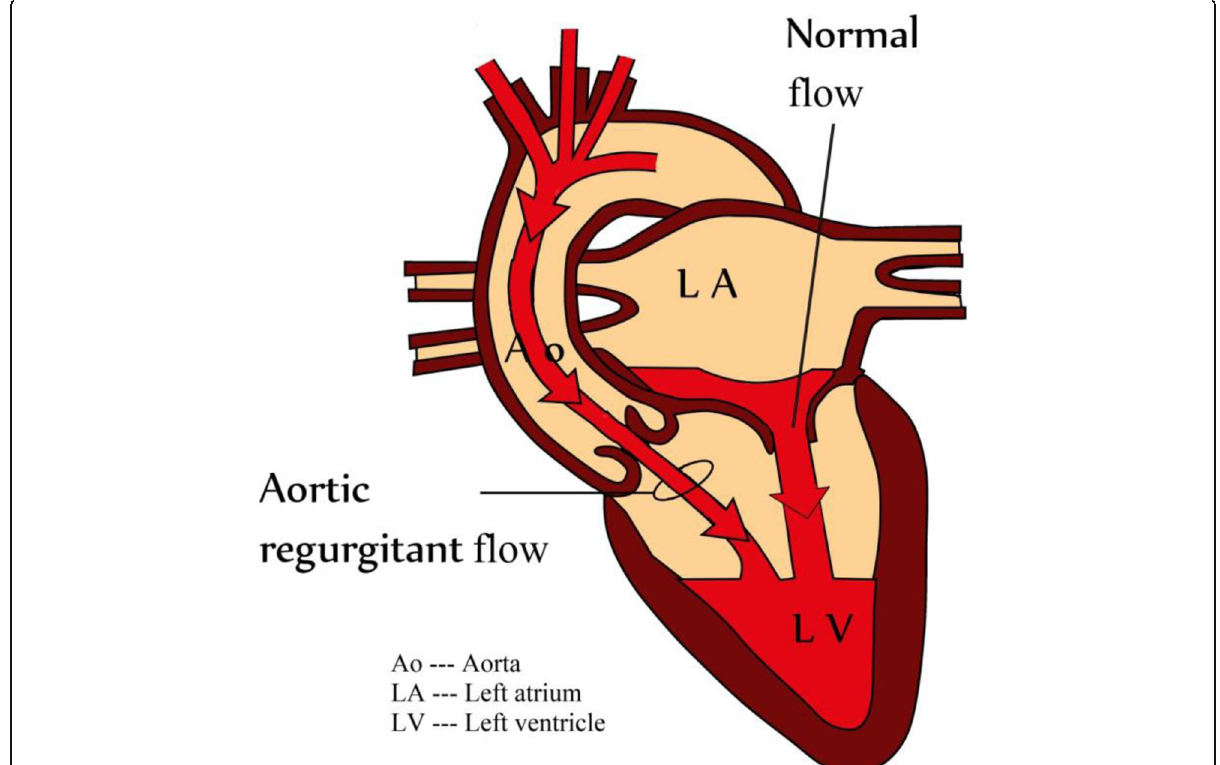
Fig. 2 In aortic valve regurgitation. The valve does not close completely during diastole with leaking of part of the ejected blood backward into the heart reducing the net ejection fraction throughout the whole cardiac